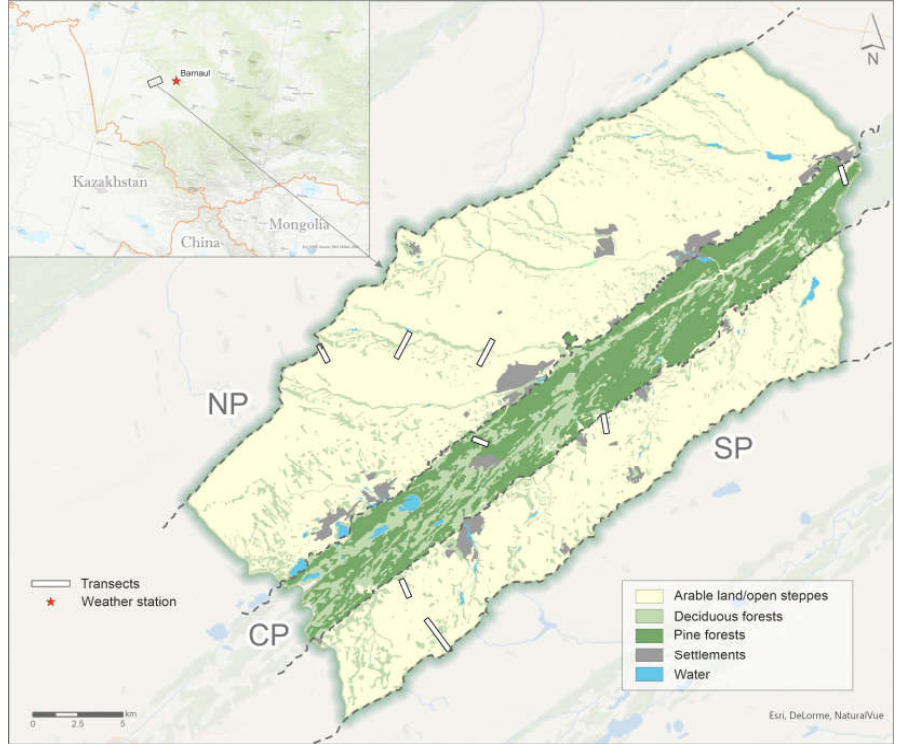
Figure 1. The Kasmala basin in the south of Western Siberia with sampling locations and land cover composition. NP—northern part, CP—central part, SP—southern part.